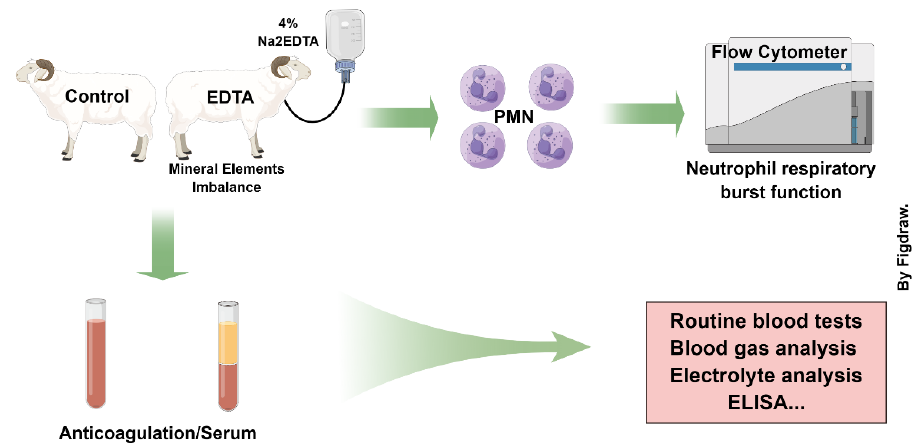
Figure 1. Experimental grouping and treatment.